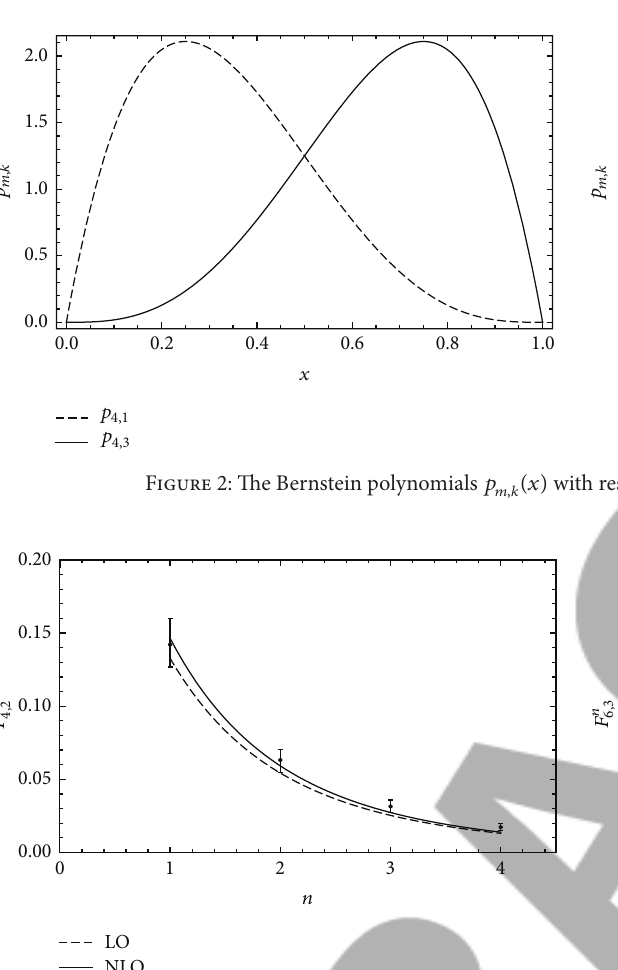
DGLAP equation, the evolution of (usual) Mellin